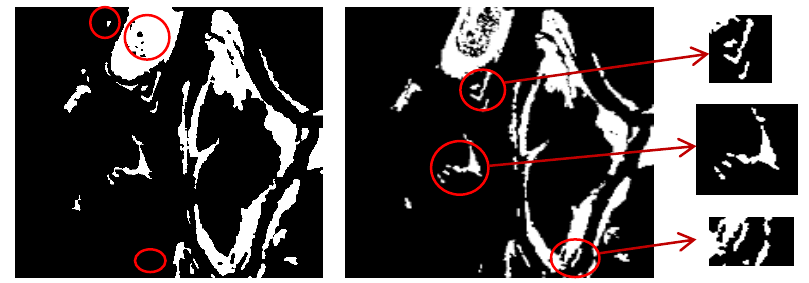
Figure 5. Detection results with details.